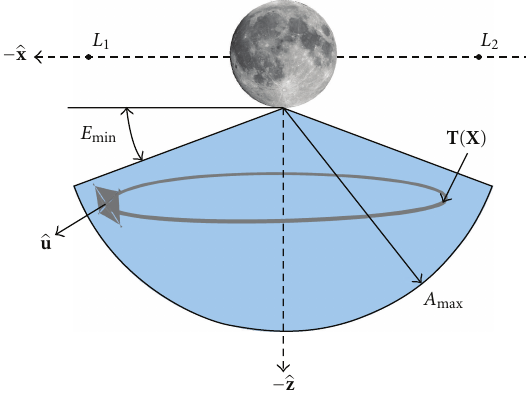
Figure 2: Path constraints for an orbit below the Moon (Moon image from nasa.gov).